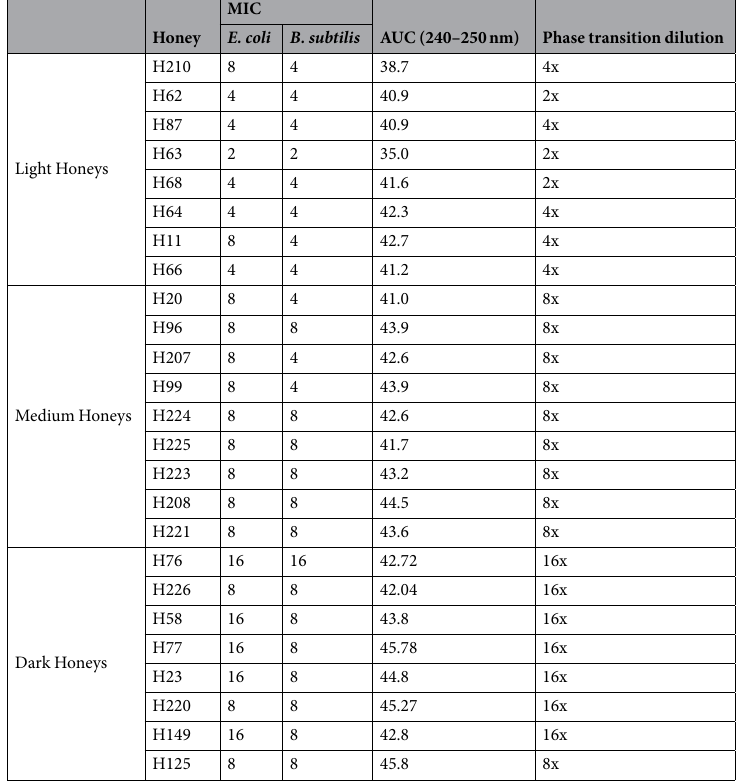
Table 4. Relationship between honey antibacterial activity, AUC (240 nm–250 nm) and the phase transition point: Comparison of the AUC values at the corresponding honey dilution before and after the loss of the 240–250 nm